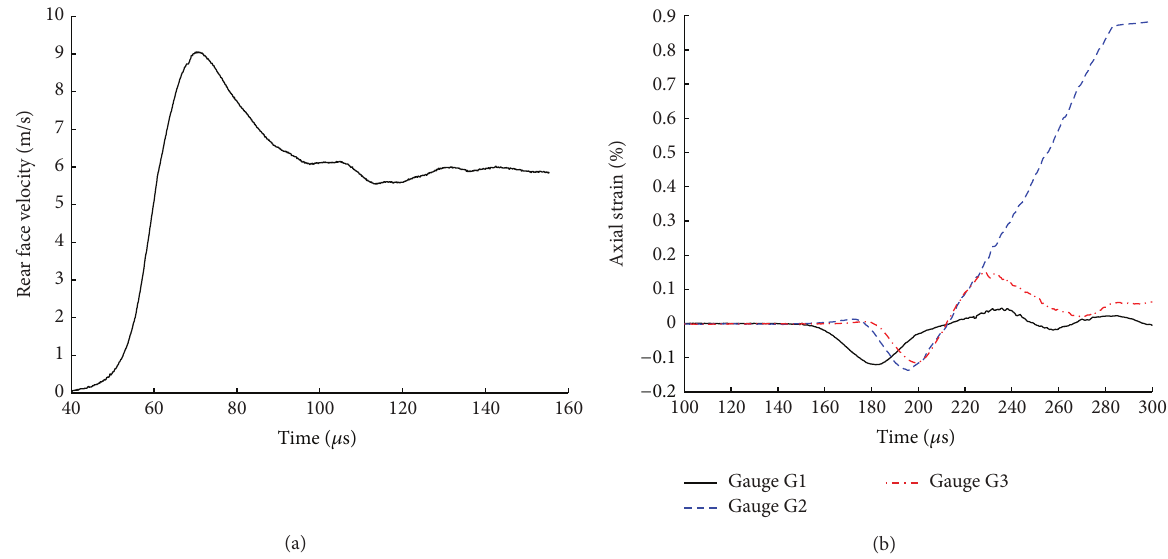
Figure 4: Spalling test results for a specimen with preexisting structural cracks. Rear face velocity from the laser (a) and strain data from the three strain gauges (b).